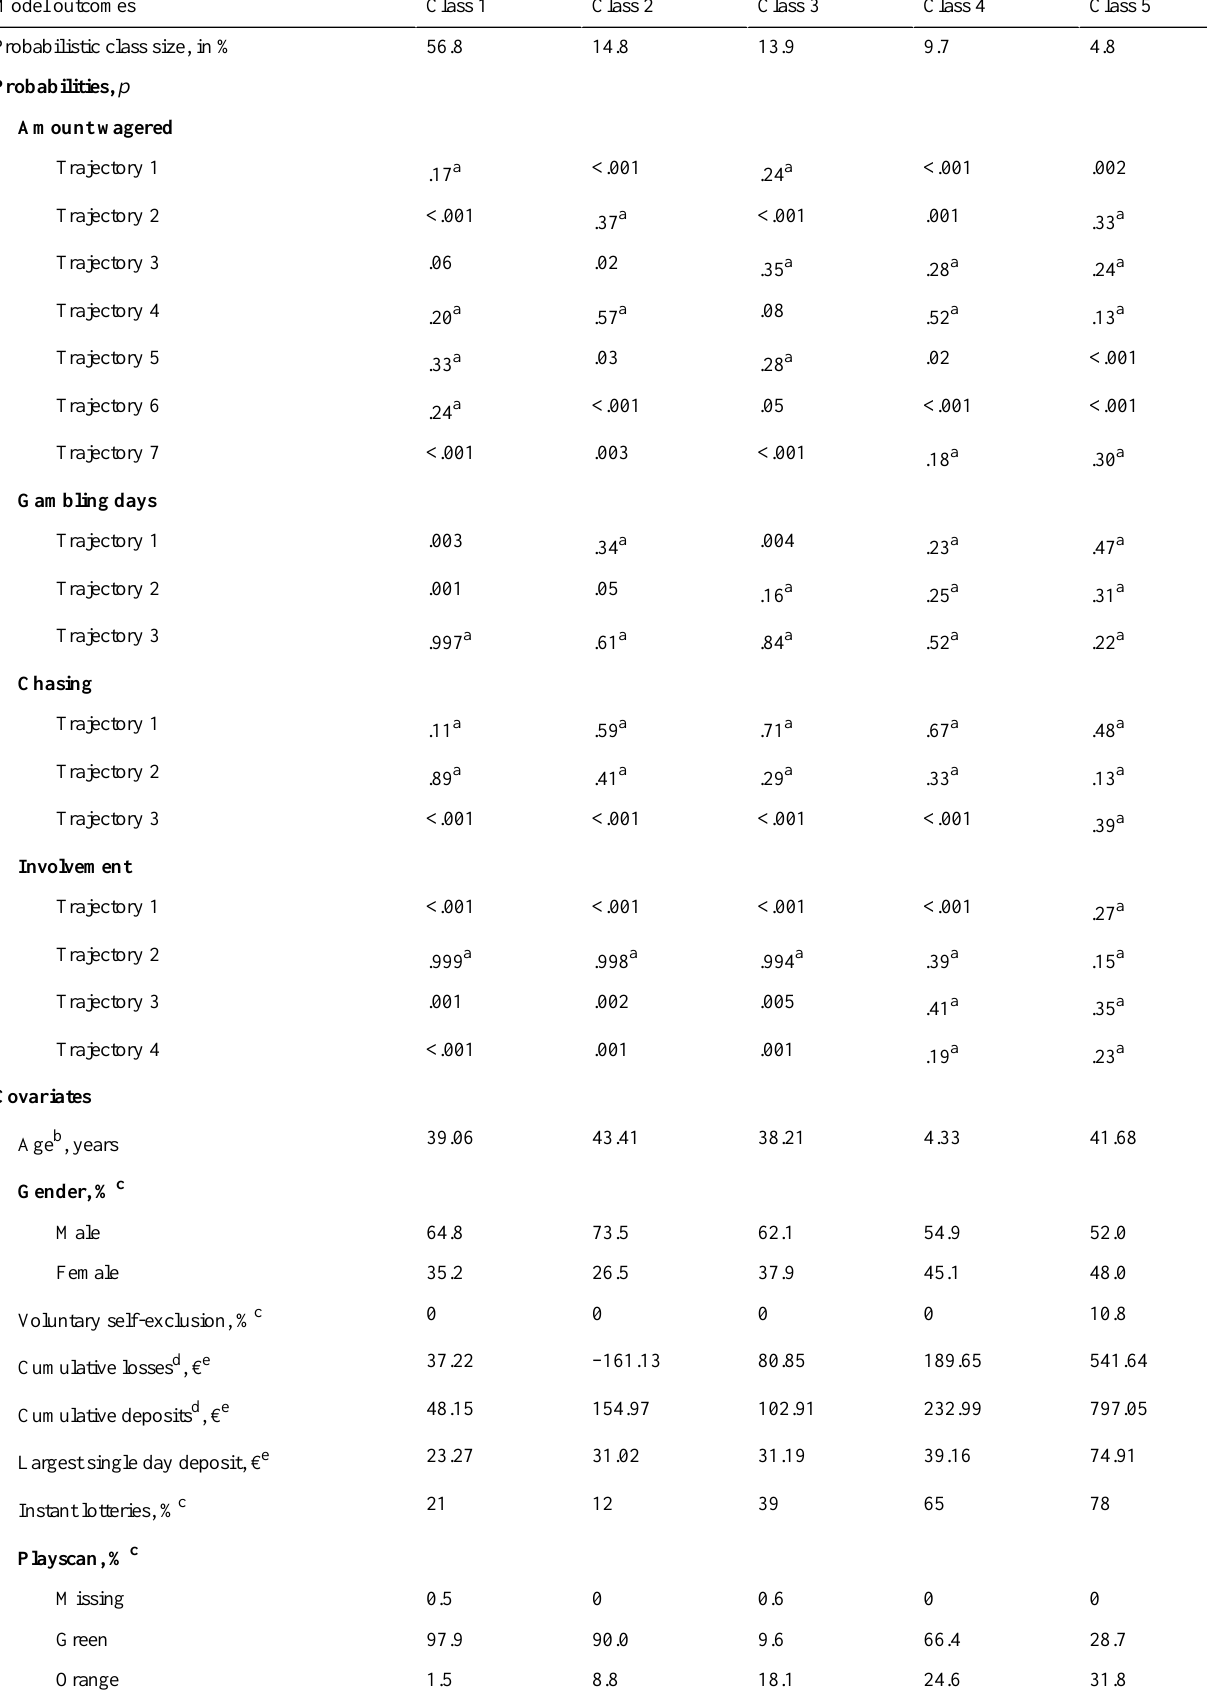
Table 3. Distribution of the trajectories for the gambling indicators and description of covariates among the 5